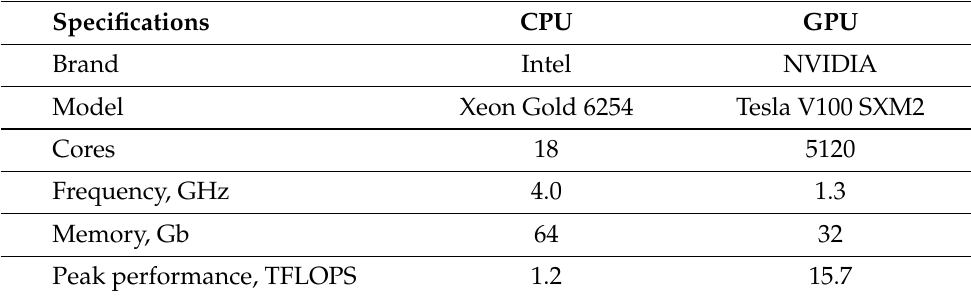
Table 2. Hardware platform of the